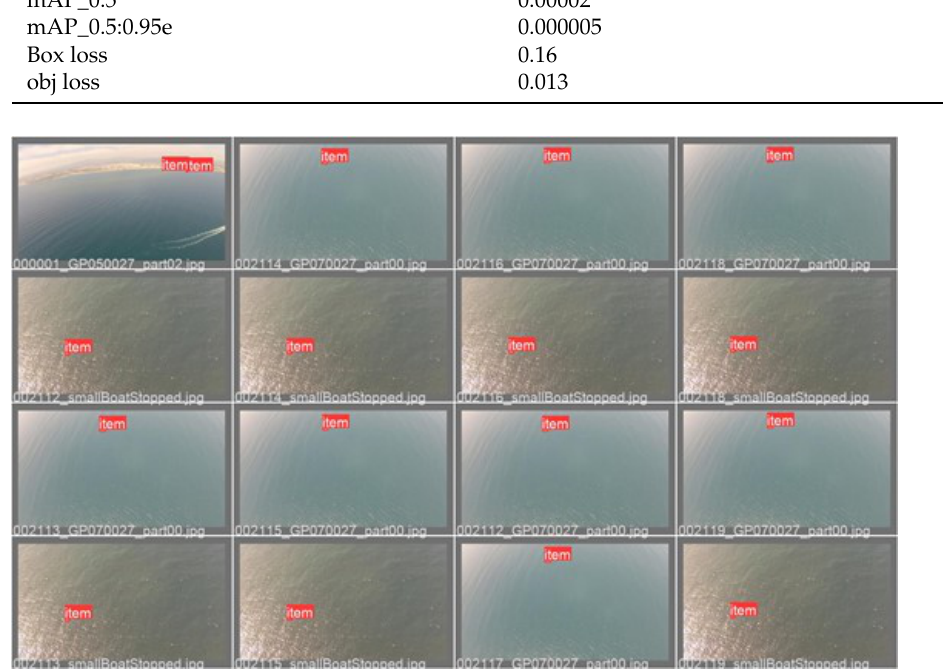
Figure 7. Examples of annotated images in the test set from SEAGULL—ground truth bounding boxes visible.